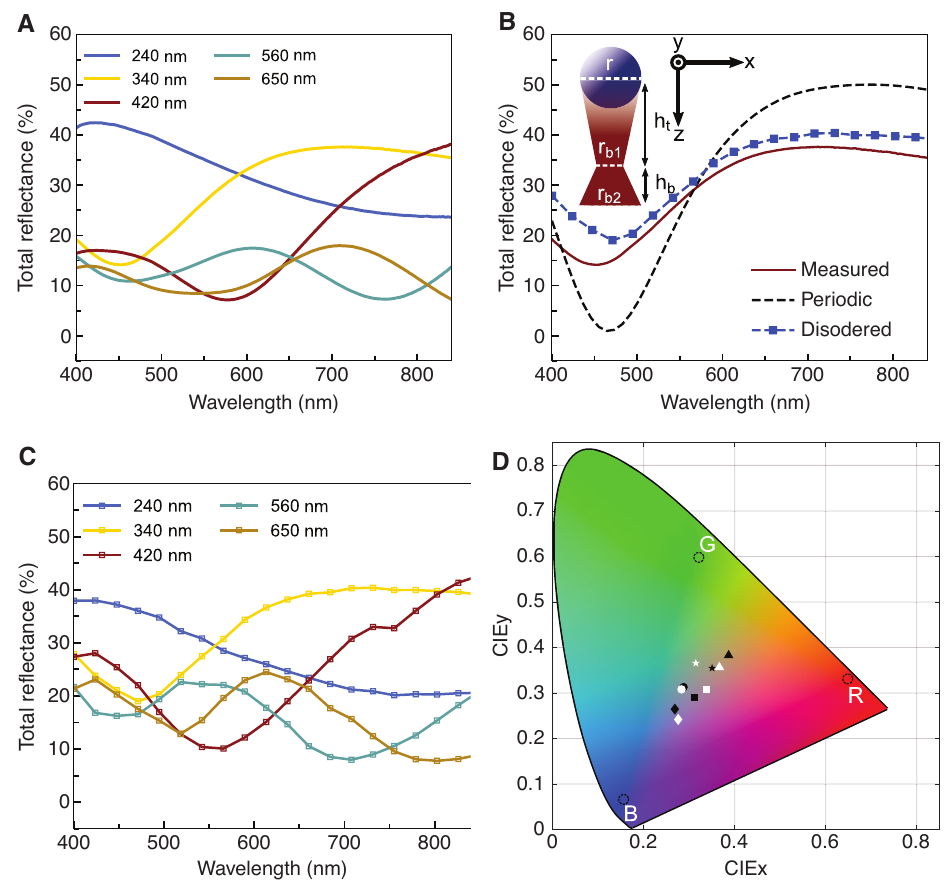
Figure 2: Total reflectance and color characteristics of DNPAs. (A) The experimentally measured total reflectance from self-assembled In/InP DNPA samples of different average heights. (B) Comparison of the experimental and simulated total reflectance from pillars with the height of ~ 340 nm demonstrates the influence of the ordered (periodic) and disordered (supercell) arrangement of pillars. Inset: Schematic of the metalo-dielectric pillar model incorporating the tapered profile of the InP pillar and In sphere at the top of the pillar. This pillar model was adopted in all of the FDTD simulations. (C) The total reflectance results from the FDTD simulations with supercell approximation on the nanopillar assemblies of different heights. (D) Representation of the measured (white) and simulated (black) reflectance colors on CIE 1931 color map. The markers – circle, triangle, diamond, star and square – are the chromaticity values for the reflective colors from the nanopillar assemblies with heights of 240 nm, 340 nm, 420 nm, 560 nm and 650 nm